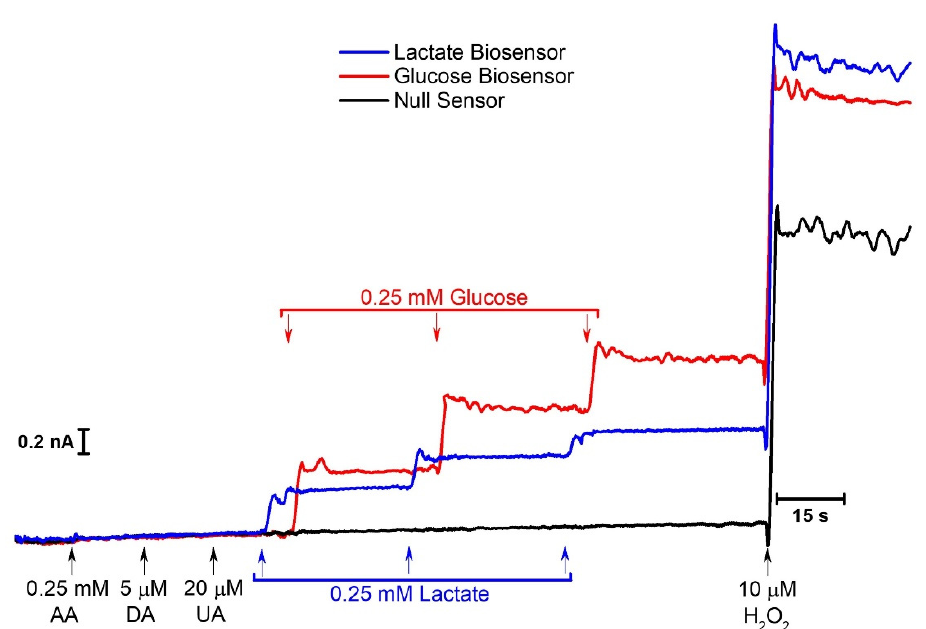
Figure 4. Representative recording of the calibration of the CFM/Pt/Nafion ® -LOx(0.5%)/PU/PD and CFM/Pt/Nafion ® -GOx(0.5%)/PD biosensor to lactate and glucose, respectively, in the presence of interferents. The recording shows the response of LOx coated (blue), GOx coated (red), and null CFM/Pt (black) to 0.25 mM of ascorbate, 10 µM of dopamine, 20 µM of uric acid, three consecutive additions of 0.25 mM of lactate and glucose, and 10 µM of H 2 O 2 .